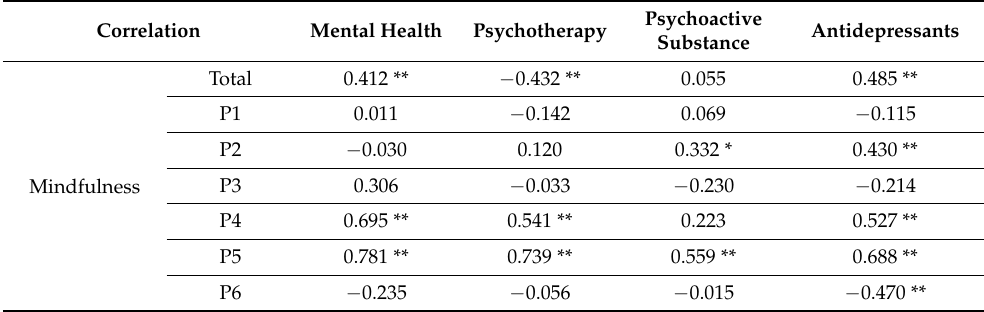
Table 1. Pearson’s correlation between the search term ‘Mindfulness’ and four other search terms over time.